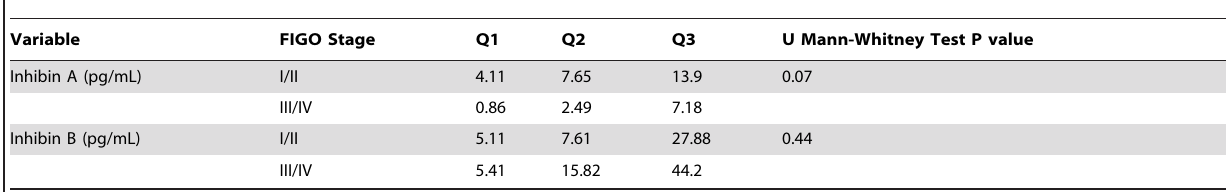
FIGO stage- the International Federation of Gynecology and Obstetrics stage; Q1: lower quartile; Q2: median; Q3: upper quartile.